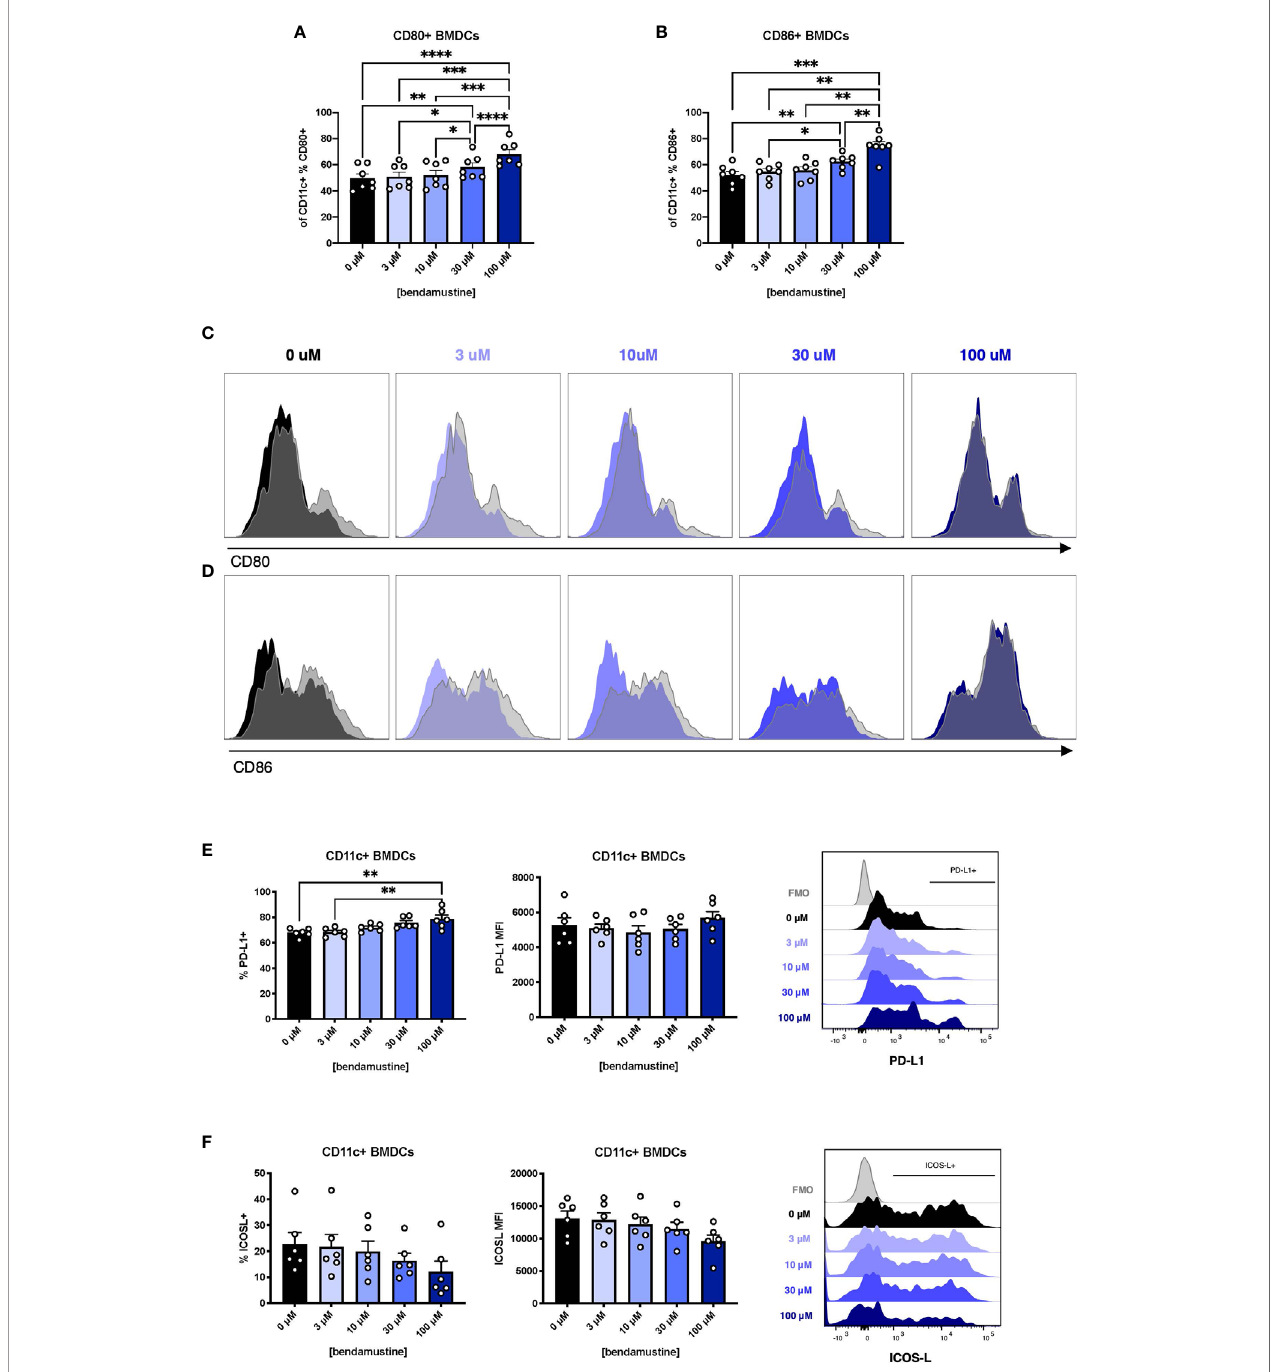
FIGURE 2 | Concentration-dependent increase in CD80, CD86, and PD-L1 expression and dampened response to LPS by murine DCs exposed to BEN. (A – F) BALB/c FL-BMDCs were generated following brief exposure to BEN and characterized by fl ow cytometry. Data is pooled from 3 independent experiments (n=6-7). Mean percent CD80 (A) and CD86 (B) expression among CD11c + FL-BMDCs is shown with SEM. Representative histograms of CD80 (C) and CD86 (D) expression on CD11c + FL-BMDCs exposed to the indicated concentration of BEN. Unstimulated condition shown in solid color and corresponding LPS stimulated condition overlaid in gray. (E) Mean percent PD-L1 expression (left) and MFI (middle) among unstimulated CD11c + FL-BMDCs shown with SEM, and representative histogram (right). (F) Mean percent ICOS-L expression (left) and MFI (middle) among unstimulated CD11c + FL-BMDCs shown with SEM, and representative histogram (right). One-way ANOVA and Dunnett ’ s multiple comparisons test were used to determine signi fi cance among groups. *P < 0.05, **P < 0.01, ***P < 0.001, ****P <